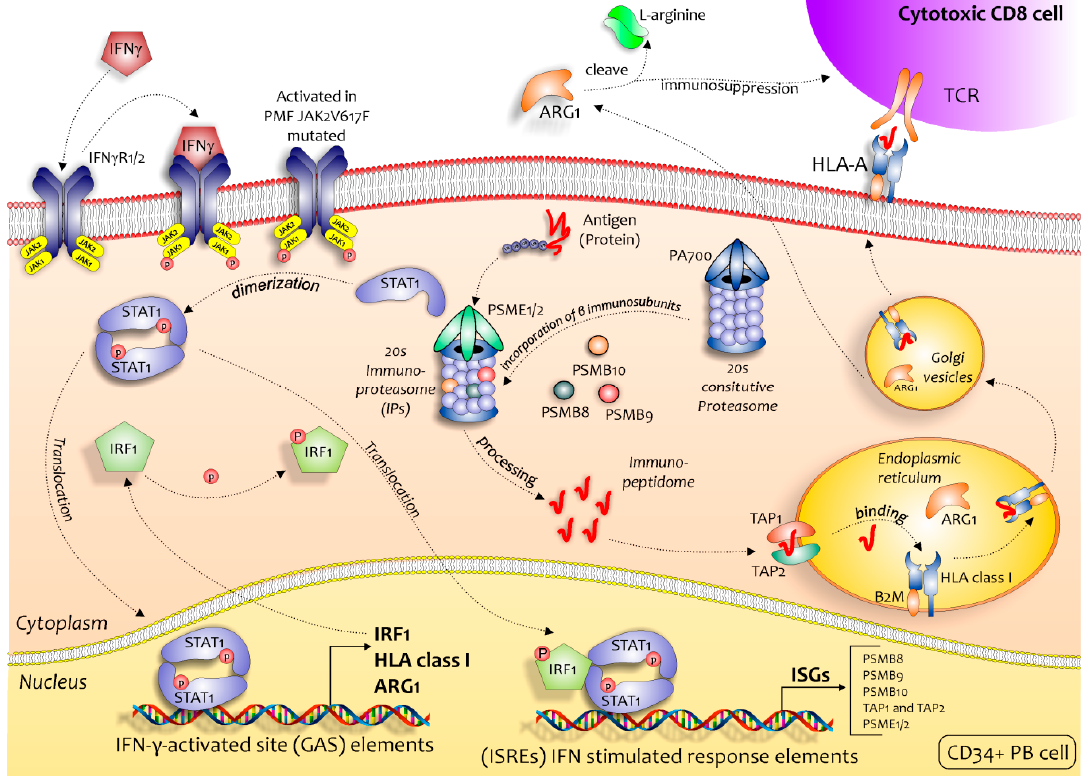
Figure 8. Regulatory role of the IPs in immune surveillance in PB CD34 + Cells of PMF JAK2 V617F mutated patients. The activation of JAK2 pathway, in a classical manner through the binding of IFNG to its receptor (IFNGR1/2) or through the JAK2 V617F mutation , induces the expression of the immunoproteasome-specific subunits β 1i (PSMB9), β 2i (PSMB10), β 5i (PSMB8), PA28 (PSME1), and PA28 (PSME2) (via STAT1 and IRF1) that result in the preferred assembly of the immunoproteasome over the regular proteasome. The resulting immuno-peptidome more effectively binds to MHC class I molecules (induced during the activation of JAK2), such that after processing in the endoplasmic reticulum (ER) (TAP1 and TAP2) and Golgi apparatus the individual peptides presented on the cell surface can be recognized by T-cell receptors on CD8 + cells, initiating an immune response (increased ARG1 expression is known to result in arginine deficiency, which leads to immunosuppression by impairing lymphocyte proliferation and activation).